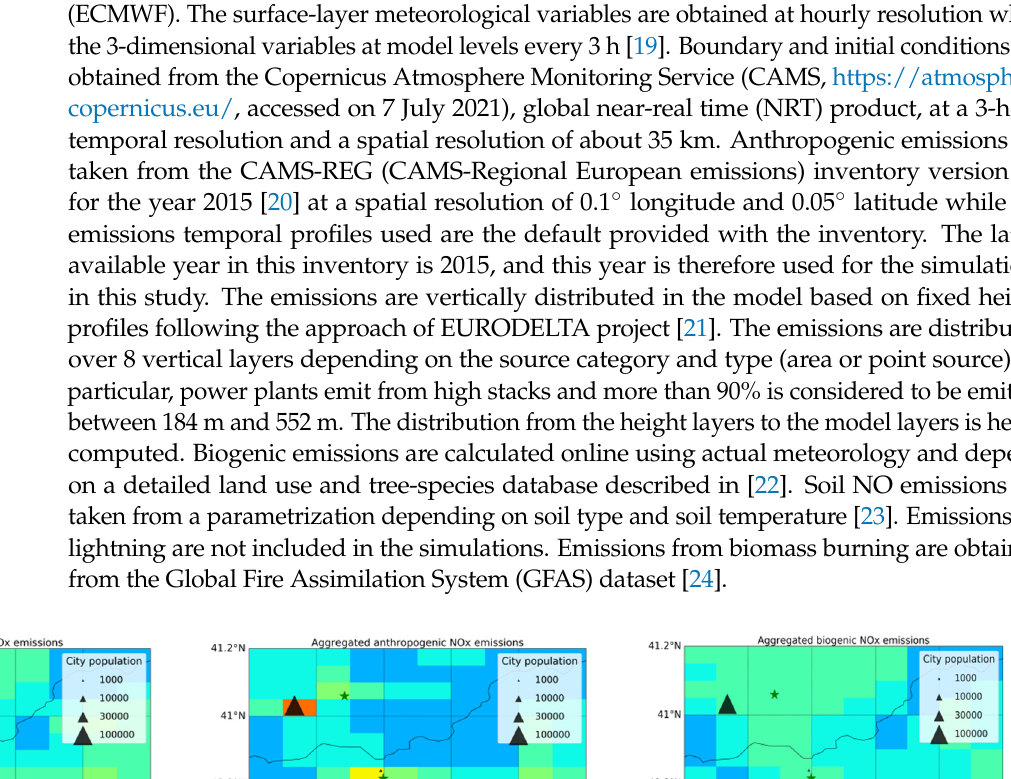
Figure 3. NO x emissions used in the model in the summer of 2019. ( a ) Total emissions; ( b ) Anthropogenic emissions; ( c ) Biogenic emissions 2019. The green stars denote the power plant locations and the size of the black triangles represent the size of city population.